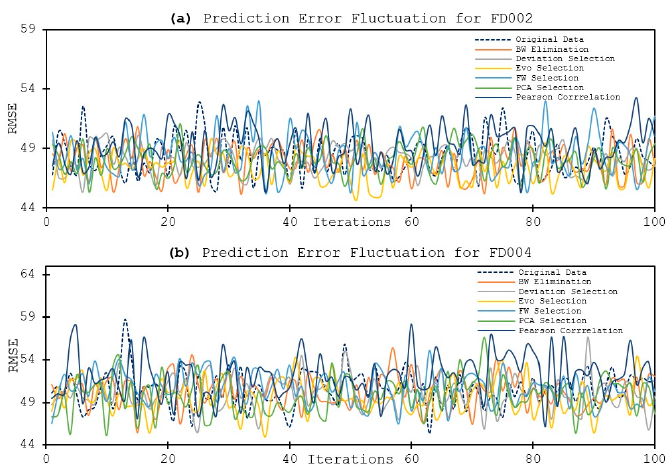
Figure 15. ( a , b ) RMSE Fluctuation for FD002 and FD004 test data.